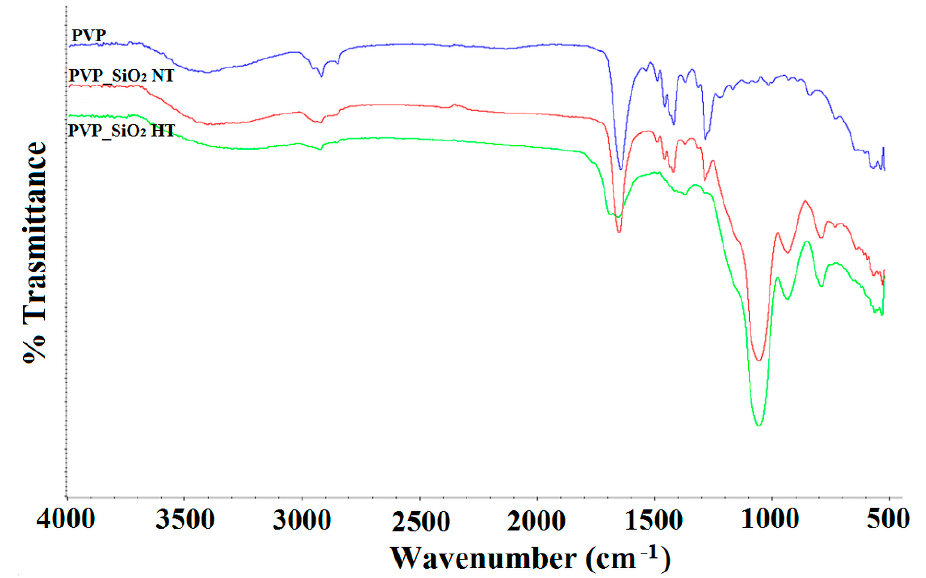
Figure 8. FTIR spectra of PVP_SiO 2 NT ( red line ), PVP_SiO 2 HT ( green line ) and pure PVP ( blue line ).